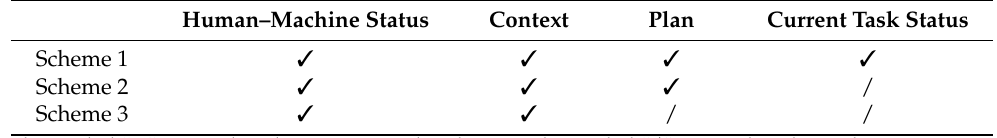
Table 2. Comparison of experimental schemes.